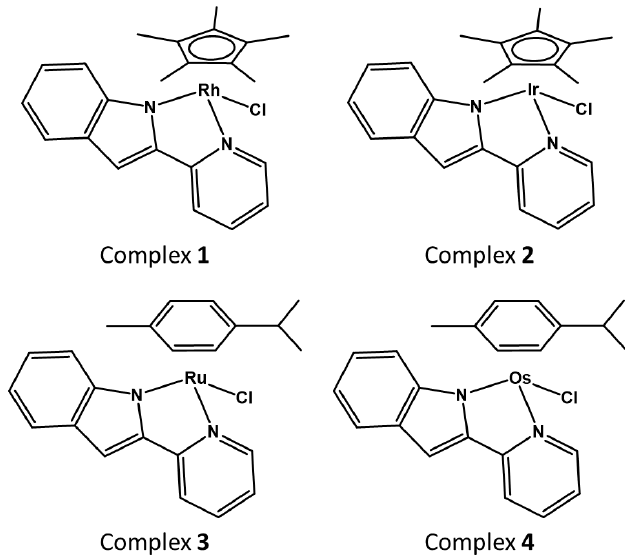
Figure 1. Molecular structures of complexes 1 – 4 .